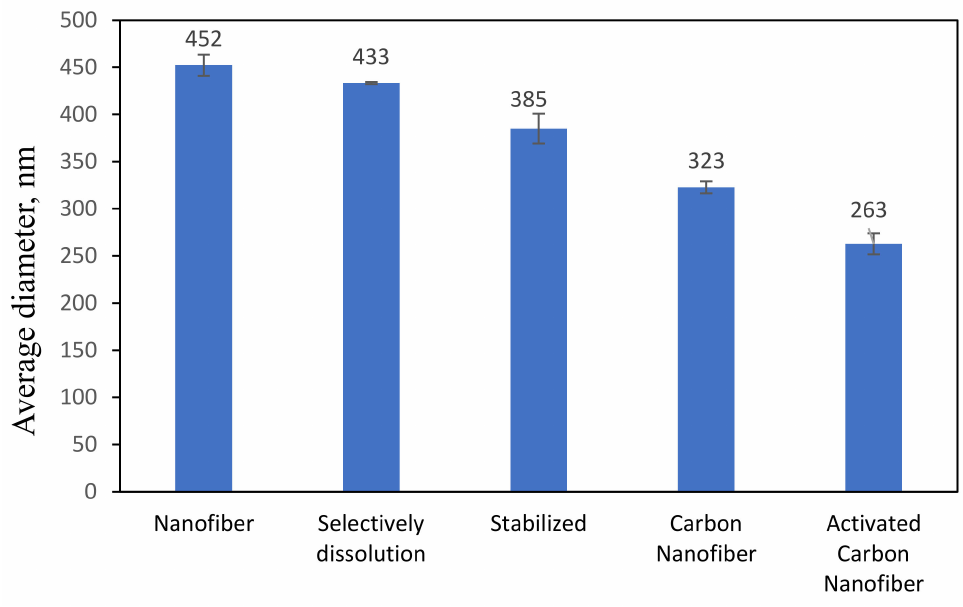
Figure 5. Average diameter of